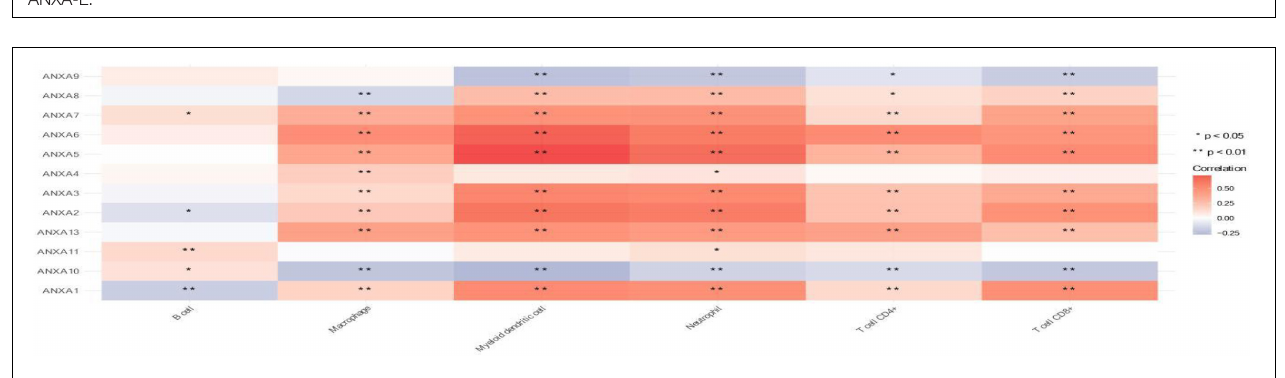
FIGURE 9 | Association of mRNA expression of ANXA family members with immune infiltration level in BC. (* p < 0.05; ** p <